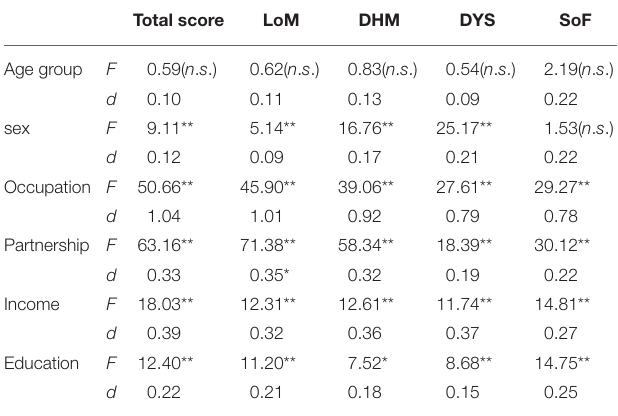
TABLE 4 | F -scores and effect sizes of group differences regarding sociodemographic variables on DS-I total score and all